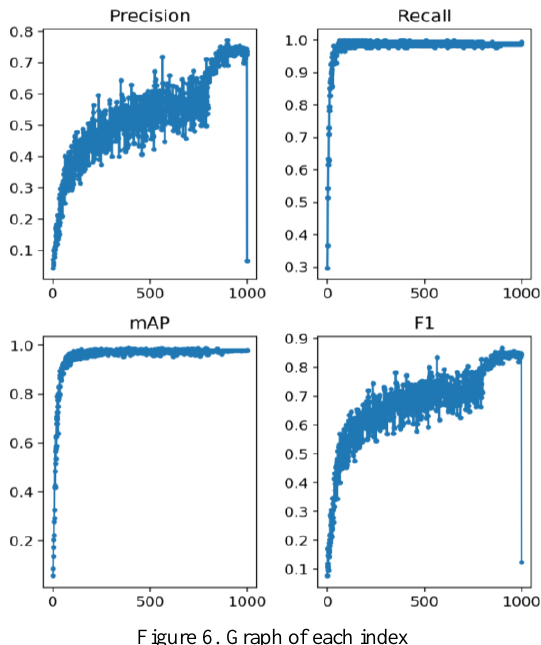
Figure 6. Graph of each index